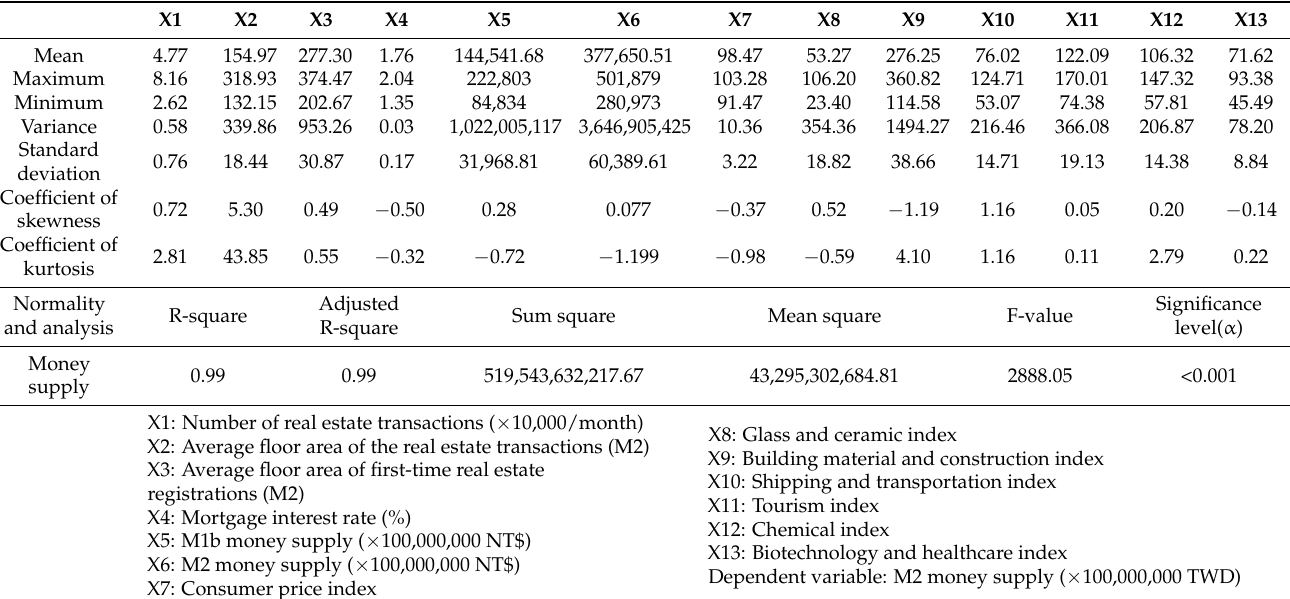
Table 1. Descriptive statistics of indexes related to money supply from January 2009 to December